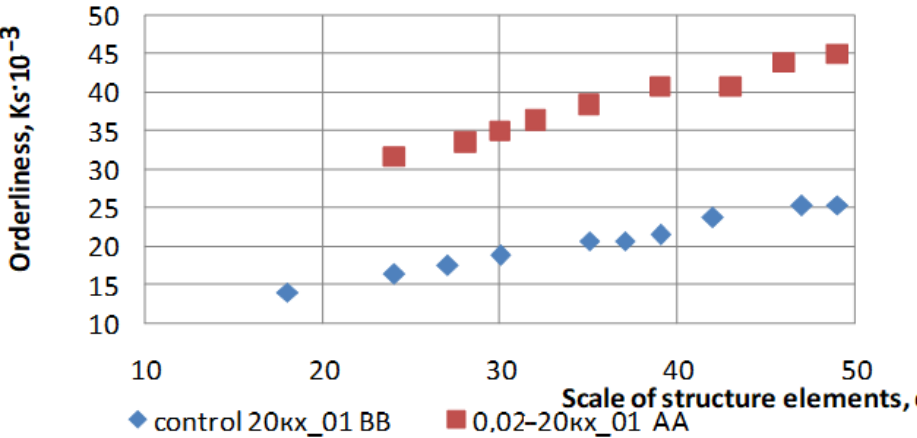
Figure 7. The effect of the d scale on change of the orderliness of K S × 10 − 3 in the spectrum of levels of dynamic state of the information system of modified and control microstructures.